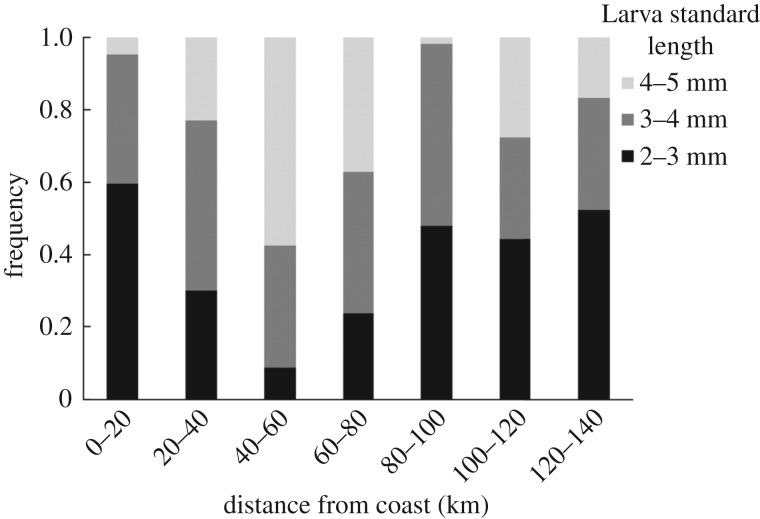
Stacked frequency histograms of larvae with respect to distance from the coast. Data are for larvae with standard length of 2–3 mm (black bars), 3–4 mm (dark grey bars) and 4–5 mm (light grey bars) in distance bins of 20 km from the coast (0 km) to the furthest stations offshore (140 km).